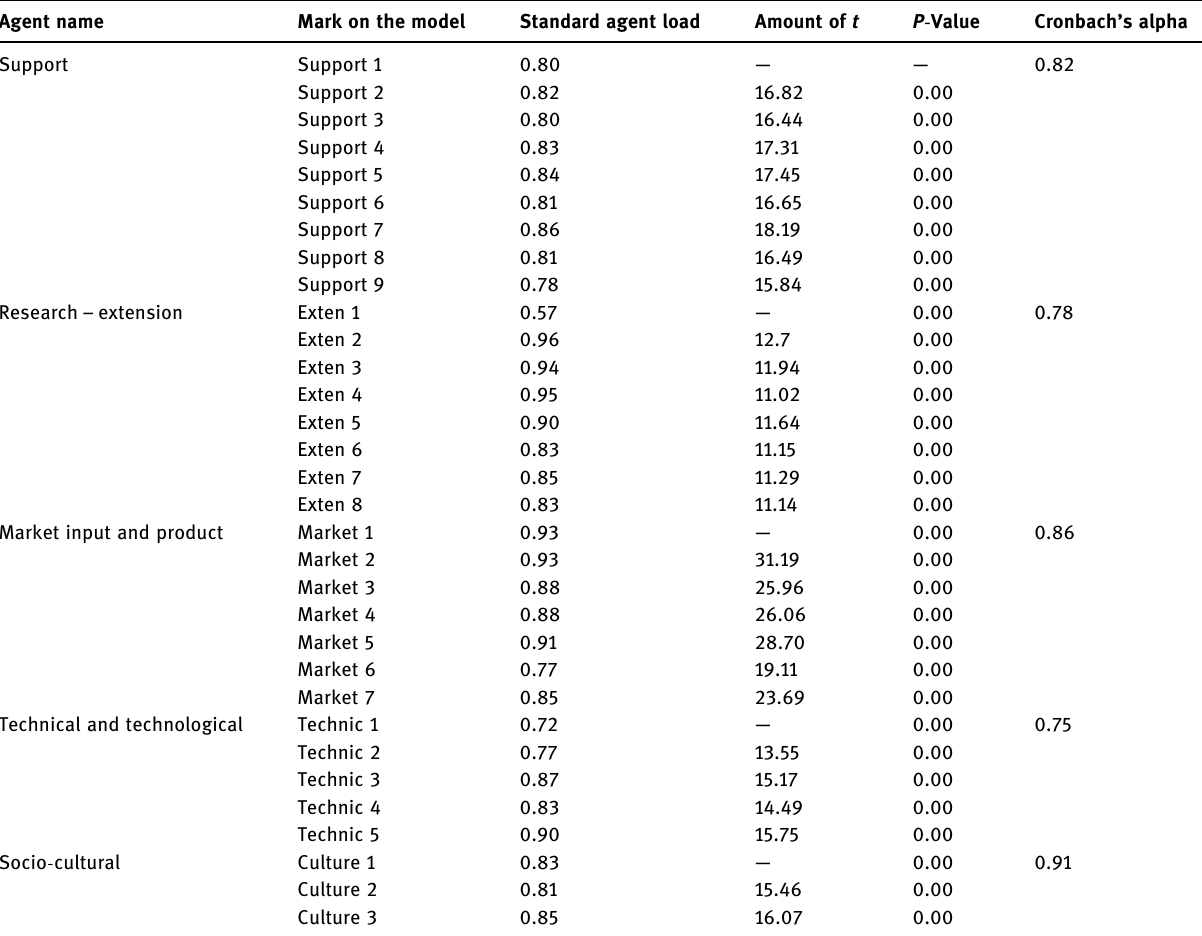
Table 8: Factor analysis of questionnaire